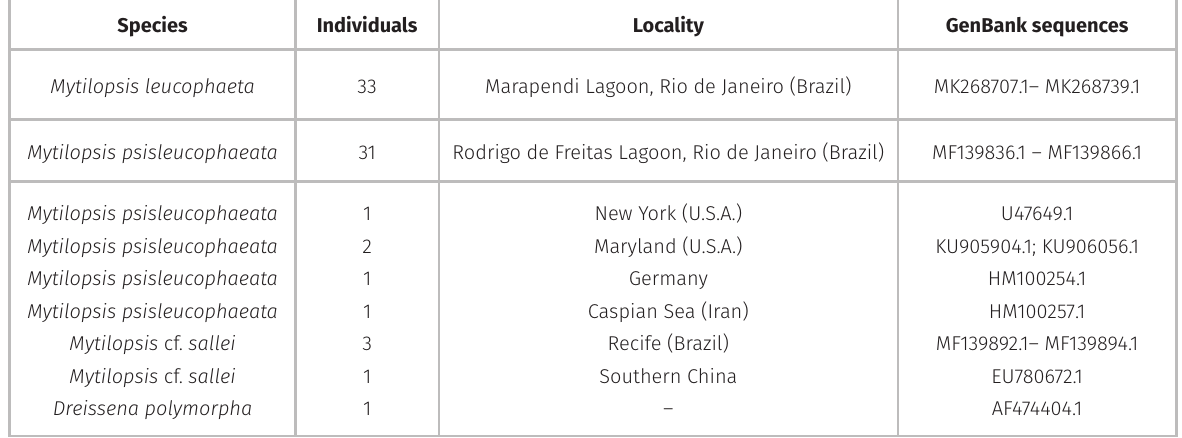
Table II. Sequences used in the present study; those from Marapendi Lagoon are new, and the remaining were retrieved from